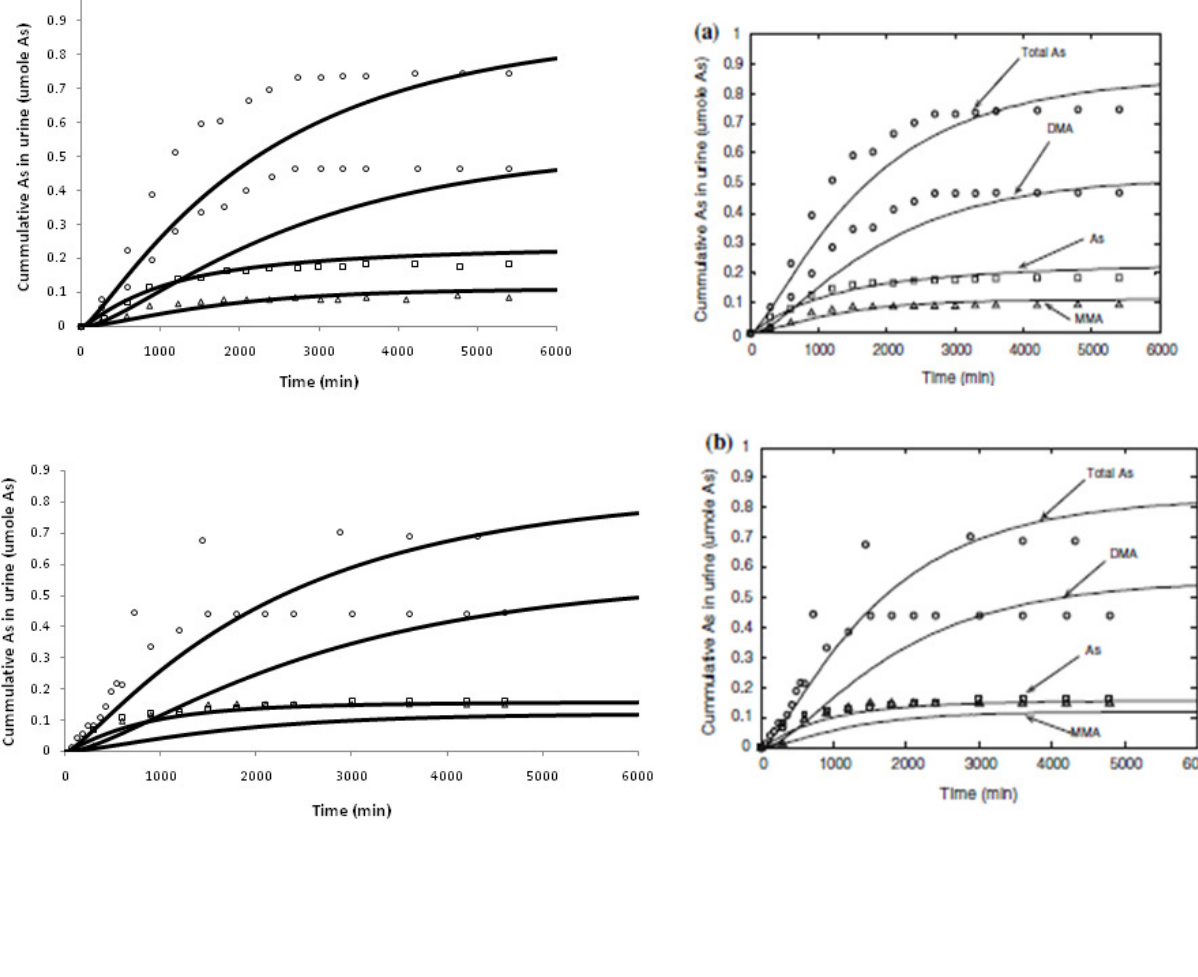
Figure 2. Total As, monomethyl arsenic (MMA), and dimethylarsenic (DMA) cumulative urinary excretion in human volunteers exposed to 100 µ g As in the form of sodium arsenate (panel a ) and sodium arsenite (panel b ). Our recoded model simulation (Left, solid line) versus the reworked original simulation by El-Masri and Kenyon, 2008 [12] (Right, solid